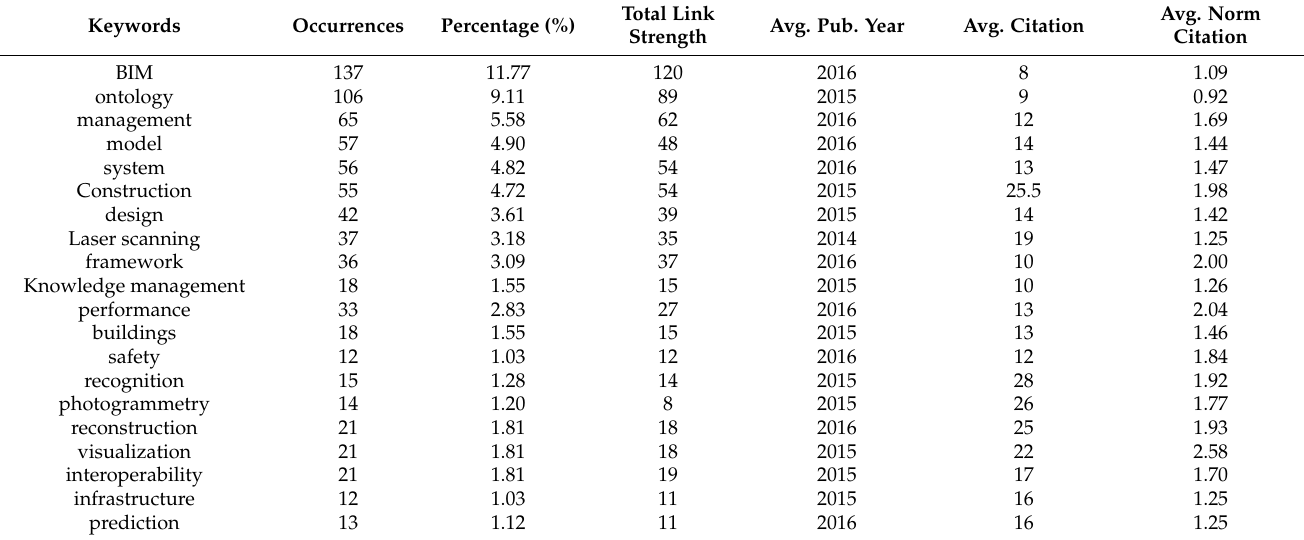
Table 1. The quantitative dimensions of the discovered